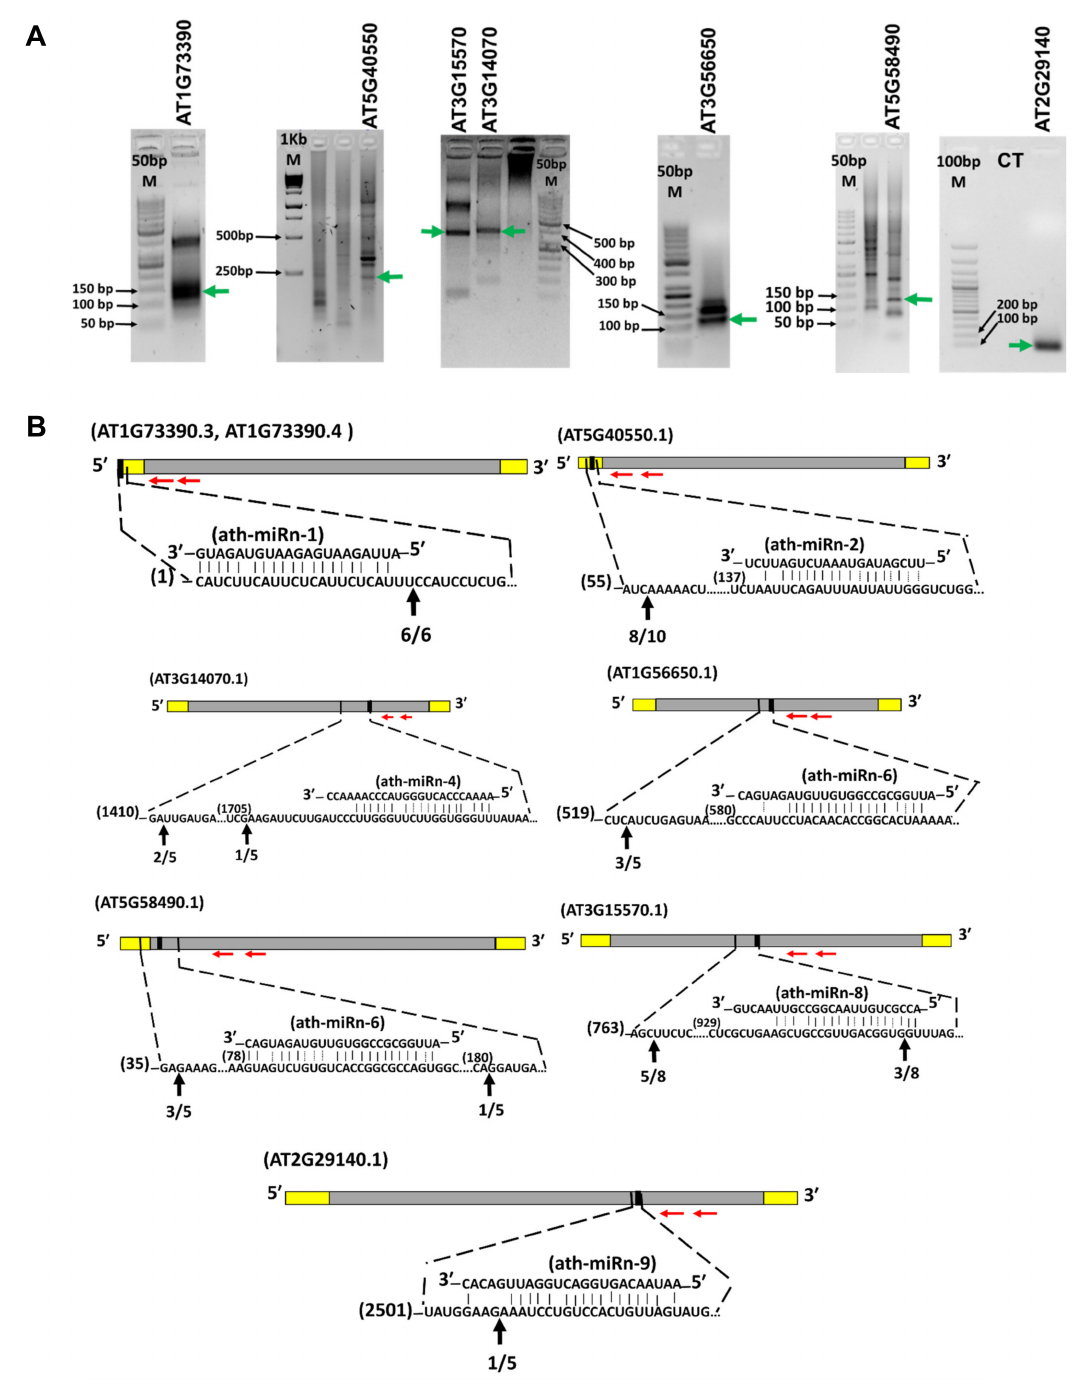
Figure 9. miRNA mapping and cleavage site determination through 5 (cid:48) RLM RACE. ( A ) Gel images of 5 (cid:48) RLM-RACE showing the amplified products (RLM-RACE second round PCR products) after consecutive PCR reactions. The migrating band in each lane (green horizontal arrows) was purified for DNA sequencing. CT: negative control for PCR; M: DNA molecular weight size marker. ( B ) The targeted mRNA section and miRNA sequences, along with mismatch(es), if any, are shown as the empty region or with dotted line. Grey boxes show CDS regions of miRNA target genes. Yellow boxes show 5 (cid:48) , 3 (cid:48) UTR ends of miRNA target genes. Black boxes show the predicted region of miRNA target site. The enlarged portion shows the pairing between miRNAs and the target sites. Each top strand depicts an miRNA, and each bottom strand depicts complementary target site on the anti-parallel miRNA. The 5 (cid:48) ends of the cleaved product determined by sequencing are indicated by the vertical arrowheads, along with the numbers of clones analyzed for each target gene. The horizontal red arrowheads indicate the gene-specific primer sites used for 5 (cid:48) RLM-RACE. Numbers in brackets show nucleotides position of target gene